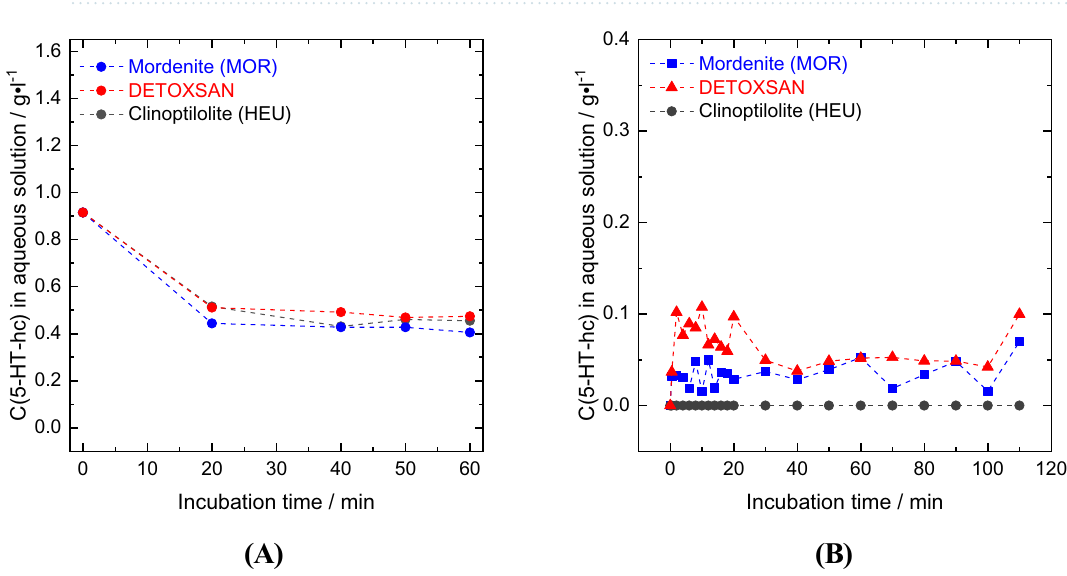
Figure 5. Uptake ( A ) and release study ( B ) of 5-HT-hc at 36 °C and a pH of 7 by different zeolites and